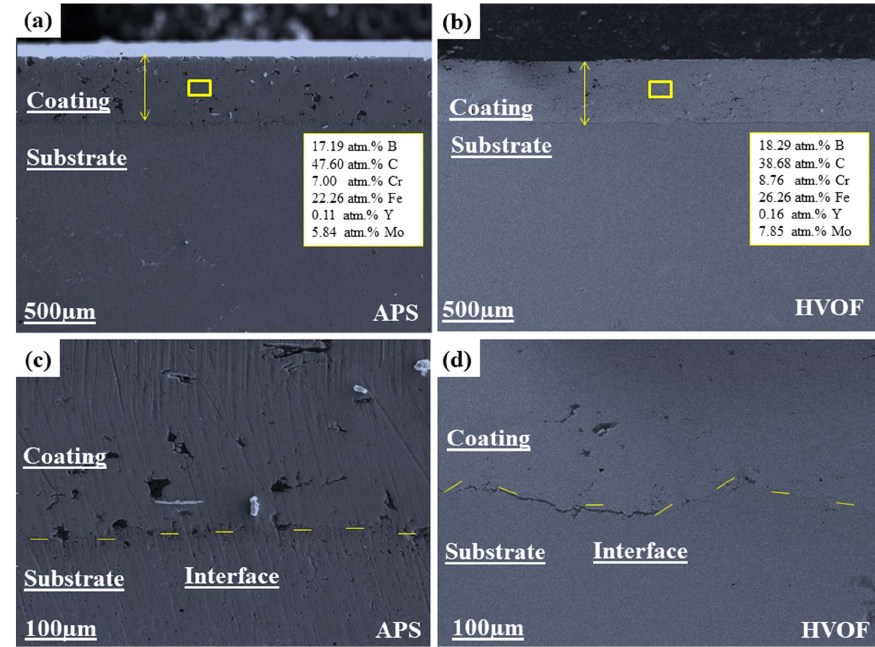
Figure 2. ( a ) Cross-section of APS-coated sample. ( b ) Cross-section of HVOF-coated sample,